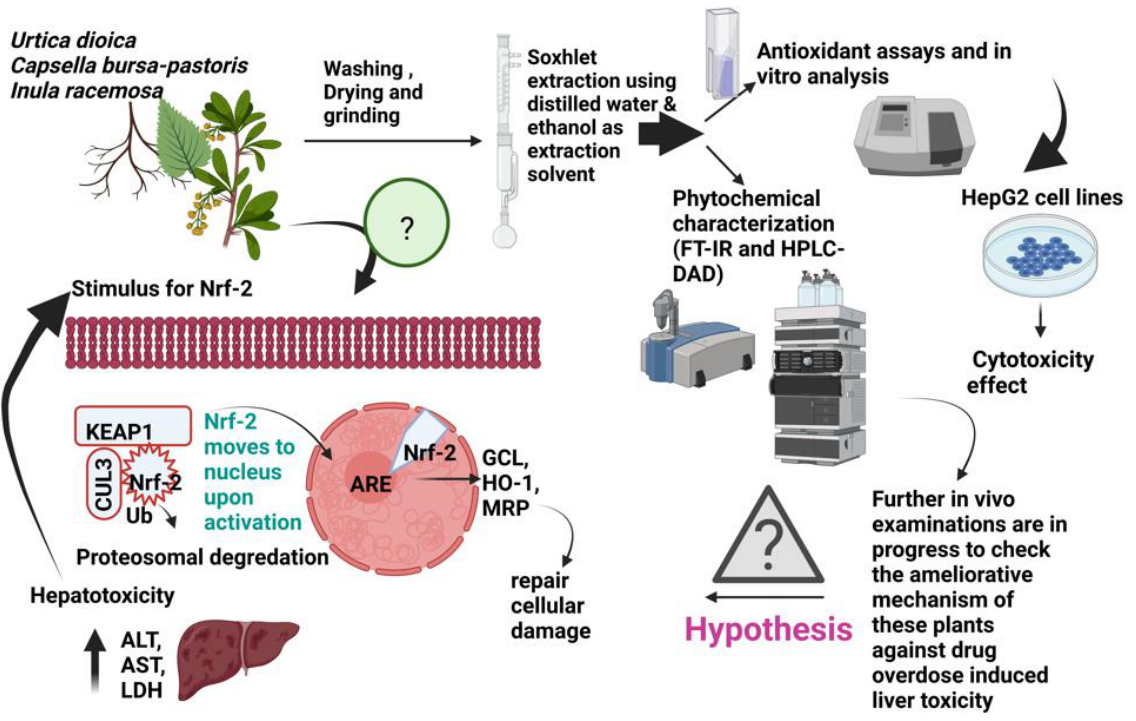
Figure 1. Graphical representation of the antioxidant activity, phenolic, and flavonoid profile cyto- toxicity activity in the leaves of UD, whole plants of CBP, and roots of IR in HepG2 cells. Further studies are in continuation on in vivo models and the hypothesis is given on the ameliorative mech- anism of these medicinal plants against the drug-induced hepatotoxicity via the Nrf2 signaling pathway [19]. Drug-induced hepatotoxicity is marked by the elevation in liver biomarkers, such as alanine aminotransferase (ALT), aspartate aminotransferase (AST), and lactate dehydrogenase (LDH). Nuclear factor erythroid 2-related factor 2 (Nrf2) is a master transcription factor that enhances the transcription of cytoprotective genes, including heme oxygenase-1 (HO-1), glutamate cysteine ligase (GCL), Mallard reaction products (MRP) and glutathione (GSH) synthesizing and conjugating enzymes, in response to oxidative, electrophilic, and xenobiotic stresses. It is well known that hepatic Nrf2 is activated by drug treatment